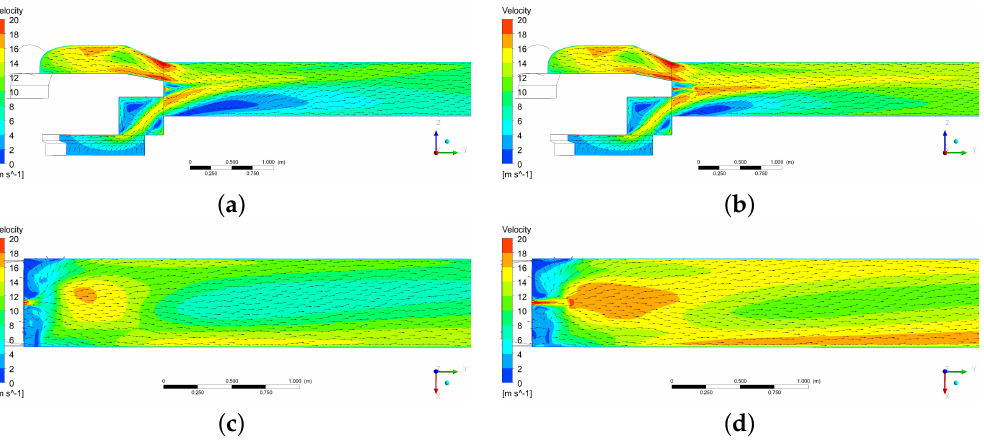
Figure 10. Velocity vectors tangentially projected on the vertical center plane on top, and the horizontal center plane below. ( a ) Hot gas flow vertical center plane. ( b ) Combustion vertical center plane. ( c ) Hot gas flow horizontal center plane. ( d ) Combustion horizontal center plane. Figure adapted from